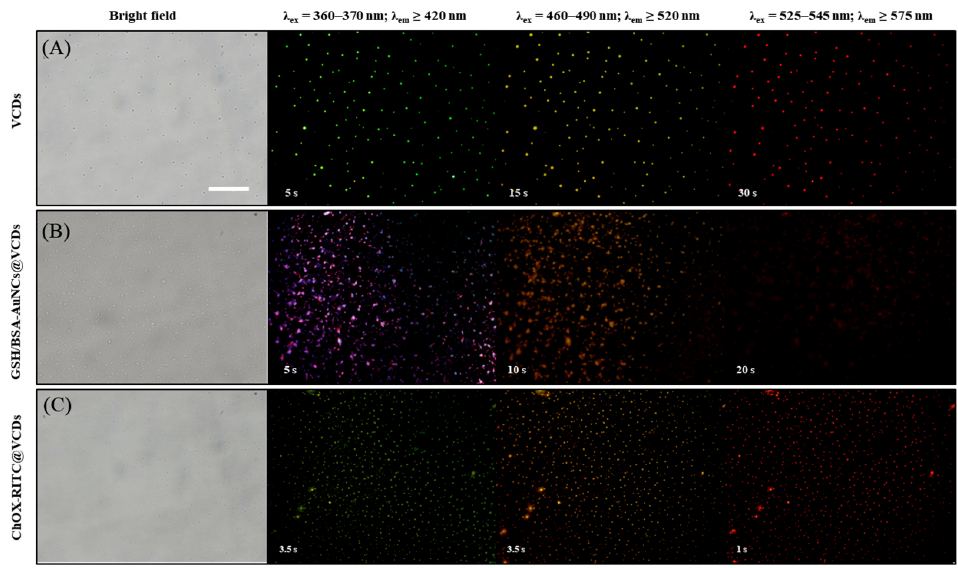
Figure 4. Bright field, blue ( λ ex = 360–370 nm; λ em ≥ 420 nm), green ( λ ex = 460–490 nm; λ em ≥ 520 nm), and red ( λ ex = 525–545 nm; λ em ≥ 575 nm) fluorescence microscopic images of ( A ) VCDs, ( B ) GSH/BSA-AuNCs@VCDs, and ( C ) ChOX-RITC@VCDs. Exposure times are labeled in the left corner of each image. Scale bar = 10 µ